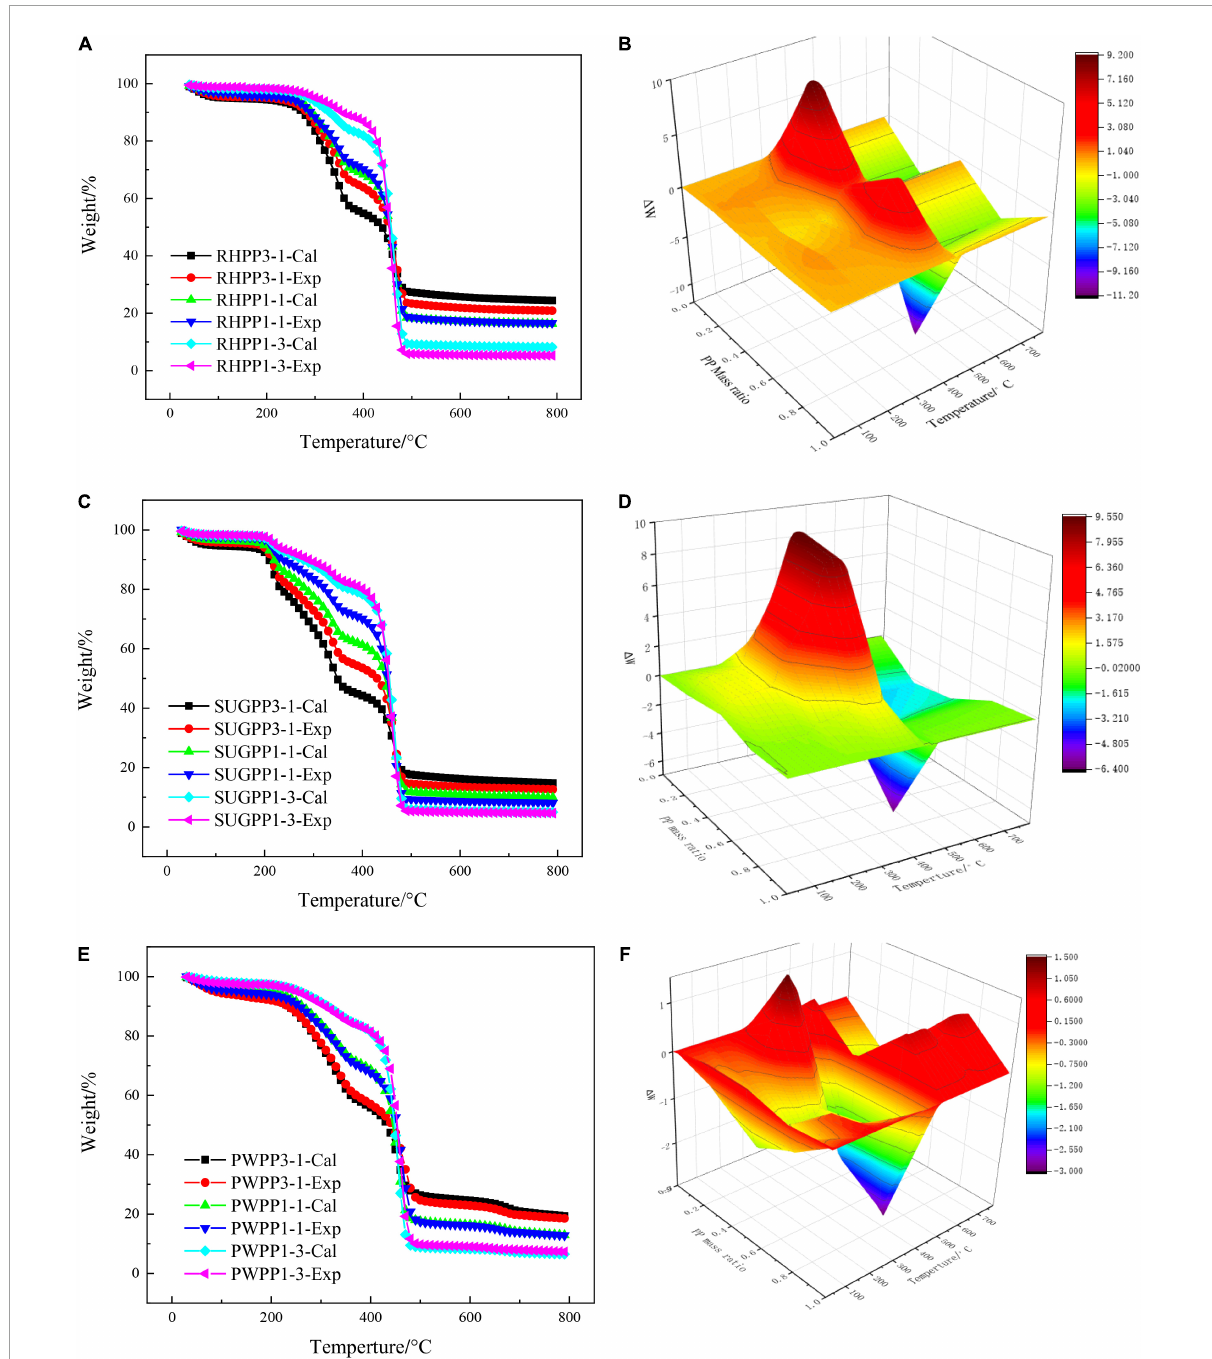
FIGURE3 TG profiles comparison between the experimental and calculated value from the mixtures under 10 ◦ C/min, (A) RH and PP mixtures, (B) (cid:49) W for RH blended with PP, (C) SUG and PP mixtures, (D) (cid:49) W versus for SUG blended with PP, (E) PW and PP mixtures, and (F) (cid:49) W for PW blended with